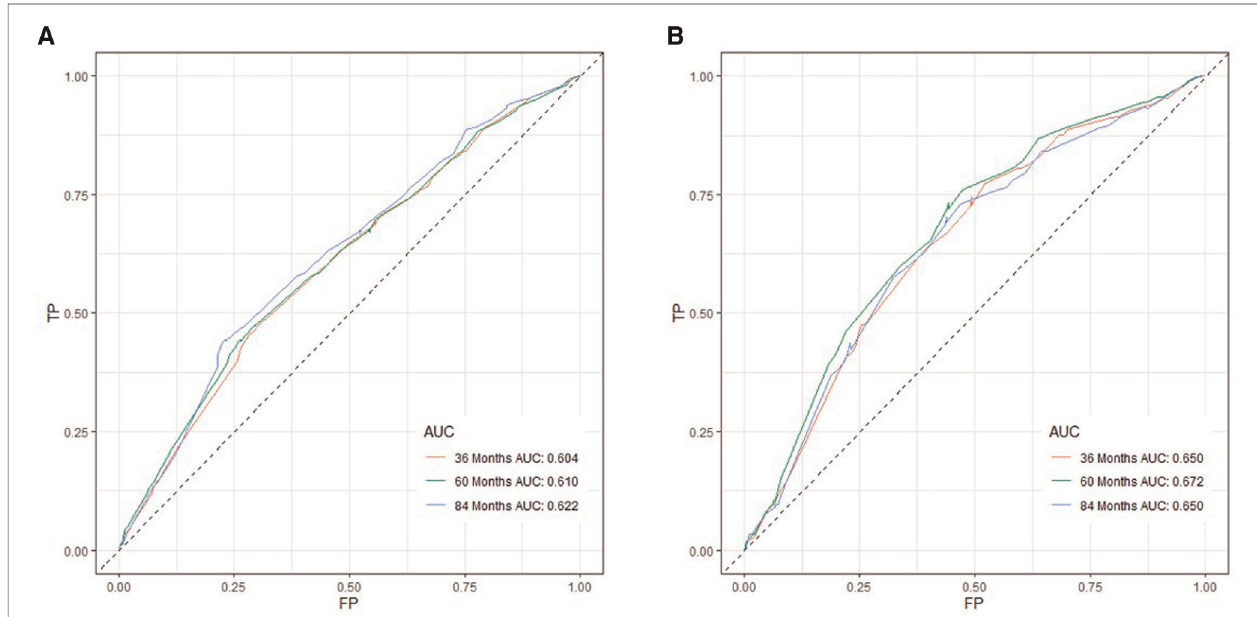
FIGURE 3 | ROC curves for survival prediction of patients receiving neoadjuvant therapy plus surgery. ( A ) ROC curves of 36-, 60-, and 84 months in the training cohort, ( B ) ROC curves of 36-, 60-, and 84 months in the validation cohort. TP, true positive rate; FP, false positive rate; ROC, receiver operating